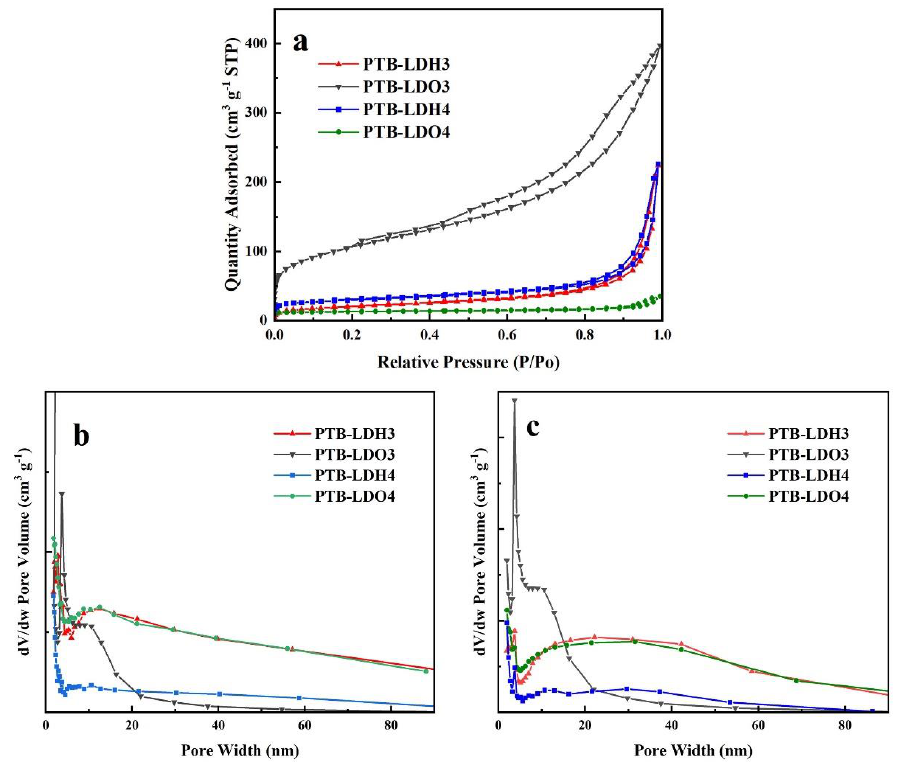
Figure 2. N 2 adsorption-desorption isotherms of PTB-LDH3, PTB-LDH4, PTB-LDO3, and PTB-LDO4 at 77 K by ( a ) BET method and ( b ) pore size distribution by BJH adsorption and ( c ) desorption.